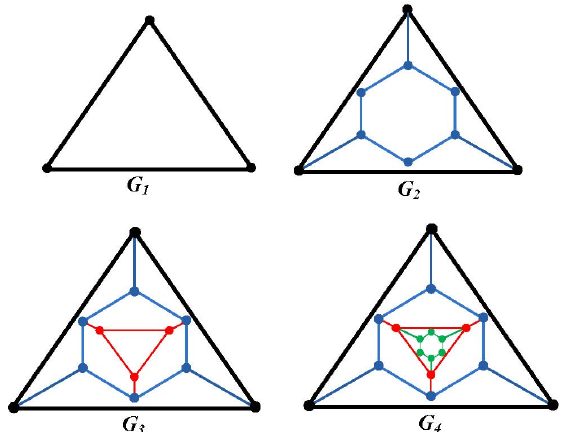
Fig. 1. The Dürer graphs G n produced at steps n = 1,2,3 and 4